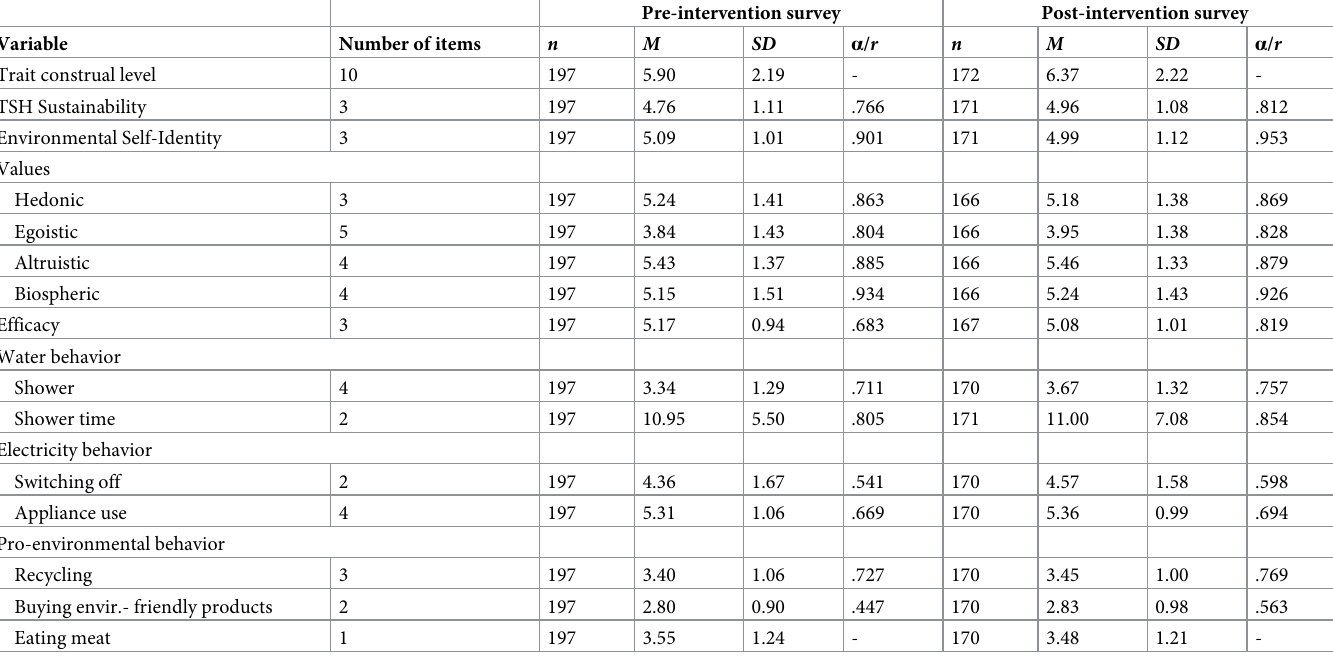
Table 1. Descriptive statistics of measures from pre-intervention and post-intervention